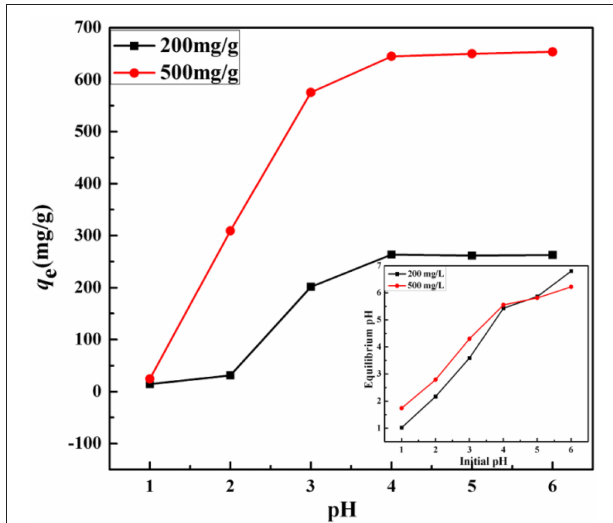
FIGURE 7 | Effect of pH on the adsorption capacity of Hg(II) onto KF@VIM/EGDMA adsorbents. Inset shows the plot of equilibrium pH against initial pH. Adsorption experiments: sample dose: 20 mg/25mL; t : 120min; temperature: 30 ◦ C.